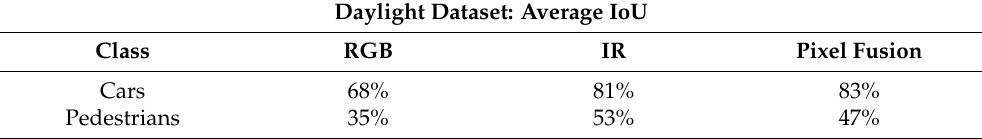
Table 3. IoU classification scores of networks trained with only daylight images. Different types of images (RGB, IR, and fused) were used in each training process. Results specify the average IoU scores in detecting and correctly classifying cars and pedestrians by the trained network compared to GT annotations.